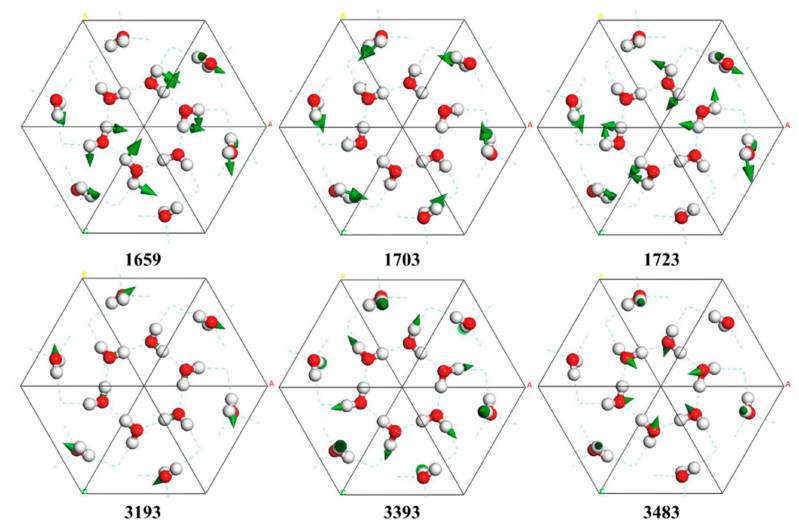
Figure 4. Top view of six normal modes in the bending band (1659, 1703, and 1723 cm − 1 ) and stretching band (3193, 3393, and 3483 cm − 1 ). The “isolated mode” can be seen in each stretching